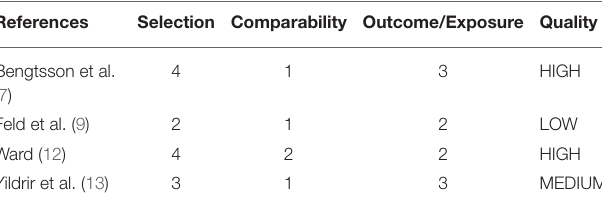
TABLE 2 | Risk of bias assessment of the cohort and case control